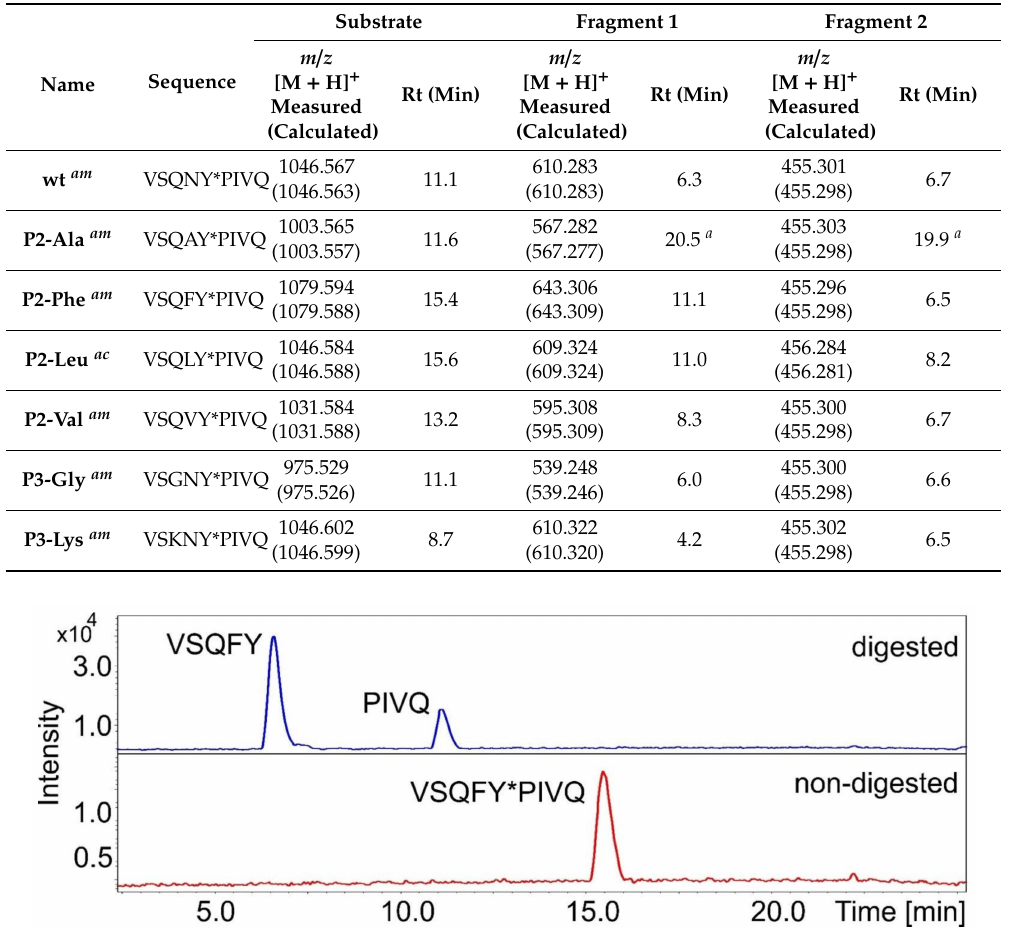
Figure 7. The base-peak chromatograms of digested and non-digested (blank) P2-Phe substrates. Further compounds were not identified. Asterisks indicate cleavage